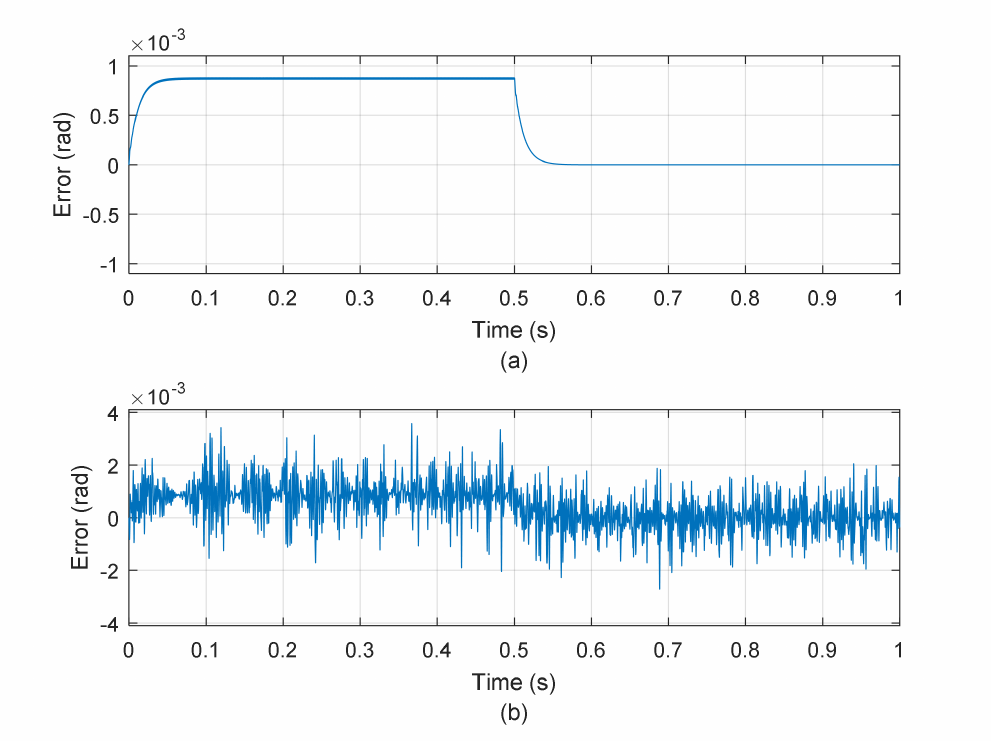
Figure 12. Simulation results for the ATO in [56]. ( a ) Without noise; ( b ) with noise.